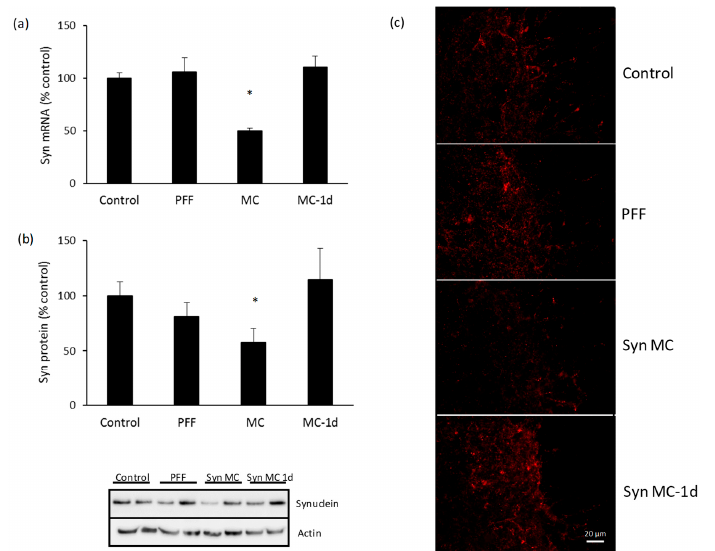
Figure 5. Alpha-synuclein downregulation in spinal cord of mice treated with anti-alpha-synuclein shRNA-MC RVG-EV after the development of alpha-synuclein pathology. Analyses of alpha- synuclein mRNA expression ( a ) and protein levels ( b ) normalized to actin. Typical western blot is shown. ( c ) Immunofluorescence images of total alpha-synuclein in cord sections. Scale bar represents 20 µ m. Values are expressed as mean ± SEM ( n = 5). * p < 0.05, non-parametric Kruskal–Wallis test. Pharmaceutics 2023 , 15 , x FOR PEER REVIEW